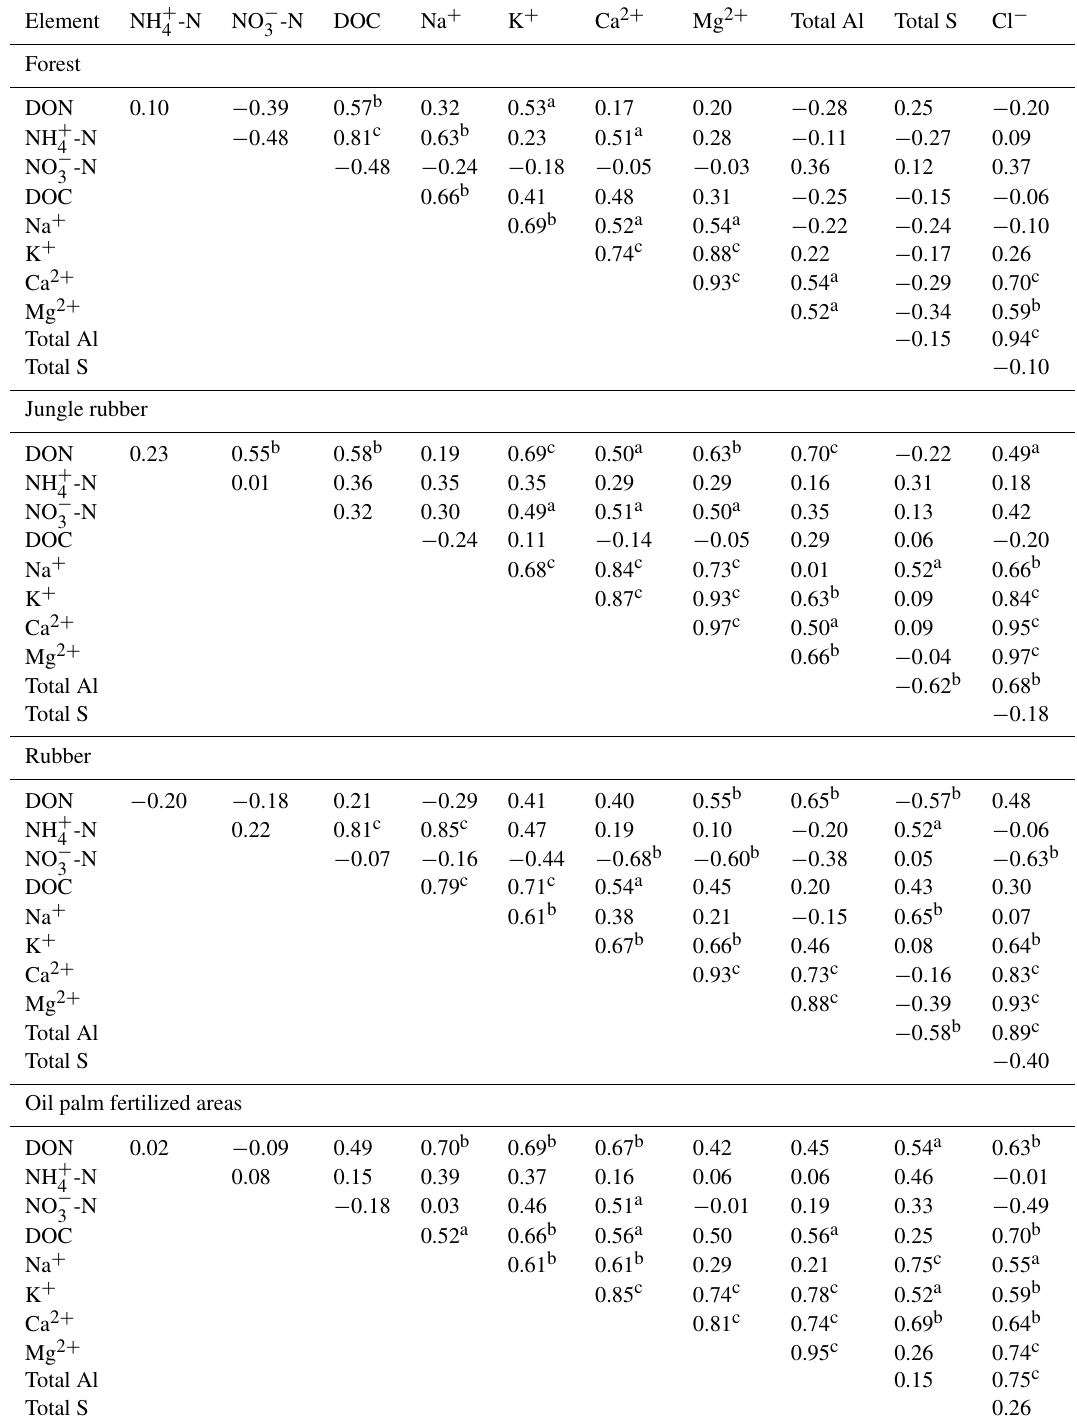
Table A4. Pearson correlations among element concentrations (mgL − 1 ) in soil solutions from a depth of 1.5m in different land uses within the clay Acrisol soil in Jambi, Sumatra, Indonesia. Correlations were carried out using monthly averages of four replicate plots per land use ( n = 12 monthly measurements in 2013). Elements that had concentrations <0.03mgL − 1 (total Fe, total Mn, and total P) and total Si that did not show correlation with other elements are not reported